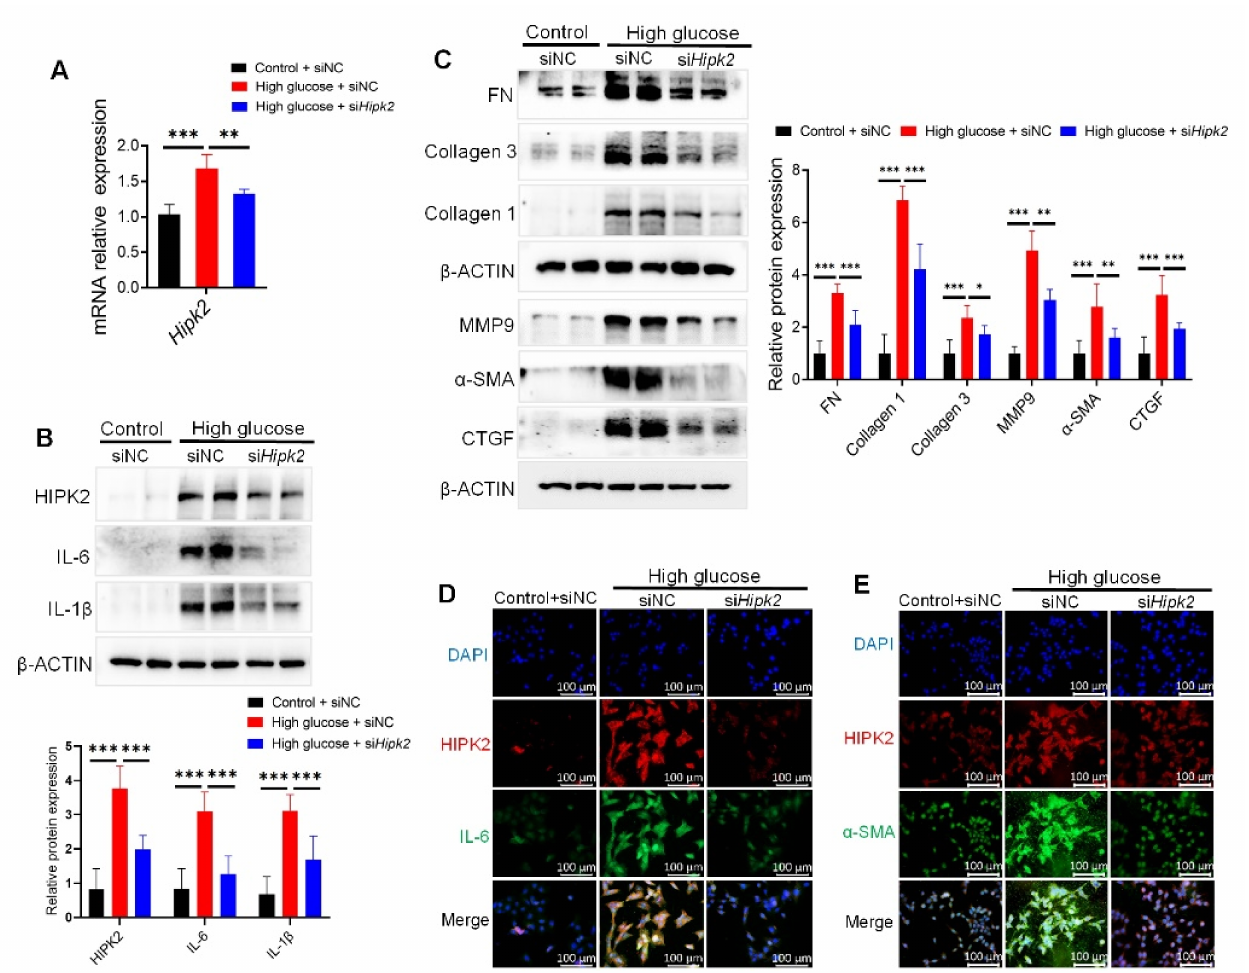
Figure 5. Loss of HIPK2 decreases fibrosis and inflammation in mesangial cells. ( A ) Quantitative RT-PCR analyses of Hipk2 in SV40-MES-13 cells treated with or without 33 mM high glucose for 24 h after transfection with negative control (siNC) or HIPK2 small interfering RNA (si Hipk2 ). Data from at least three independent experiments are shown as mean ± S.D, ** p < 0.01, and *** p < 0.001. ( B , C ) Western blot analysis of HIPK2, inflammatory mediators (IL-6 and IL-1 β ), and fibrosis markers (FN, Collagen 3, Collagen 1, MMP9, α -SMA, and CTGF) expression in SV40-MES-13 cells treated with or without 33 mM high glucose for 24 h after transfection with siNC or si Hipk2 . Data from at least three independent experiments are shown as mean ± S.D, * p < 0.05, ** p < 0.01 and *** p < 0.001. ( D , E ) Immunofluorescence staining of HIPK2, α -SMA, and IL-6 in SV40-MES-13 cells treated with or without 33 mM D-glucose for 24 h after transfection with siNC or si Hipk2